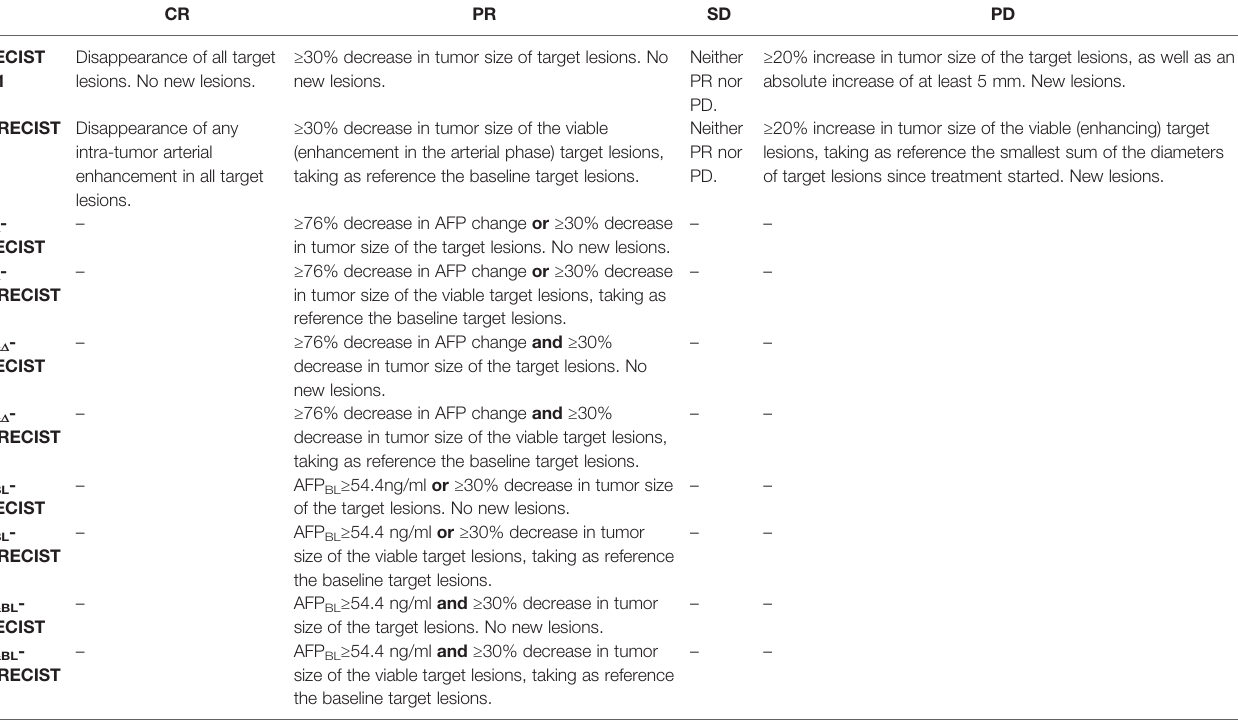
TABLE 1 | Different tumor response evaluation criteria based on RECIST 1.1, mRECIST and AFP BL , AFP D . CR PR SD PD RECIST Disappearance of all target 1.1 lesions. No new